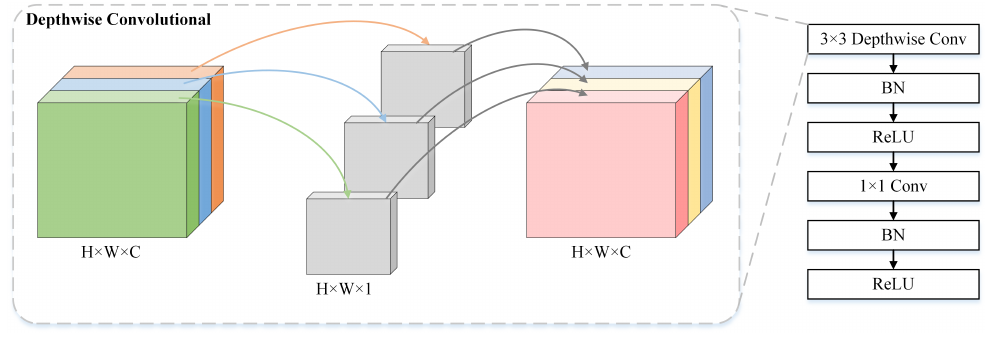
Figure 31. Depthwise Separable